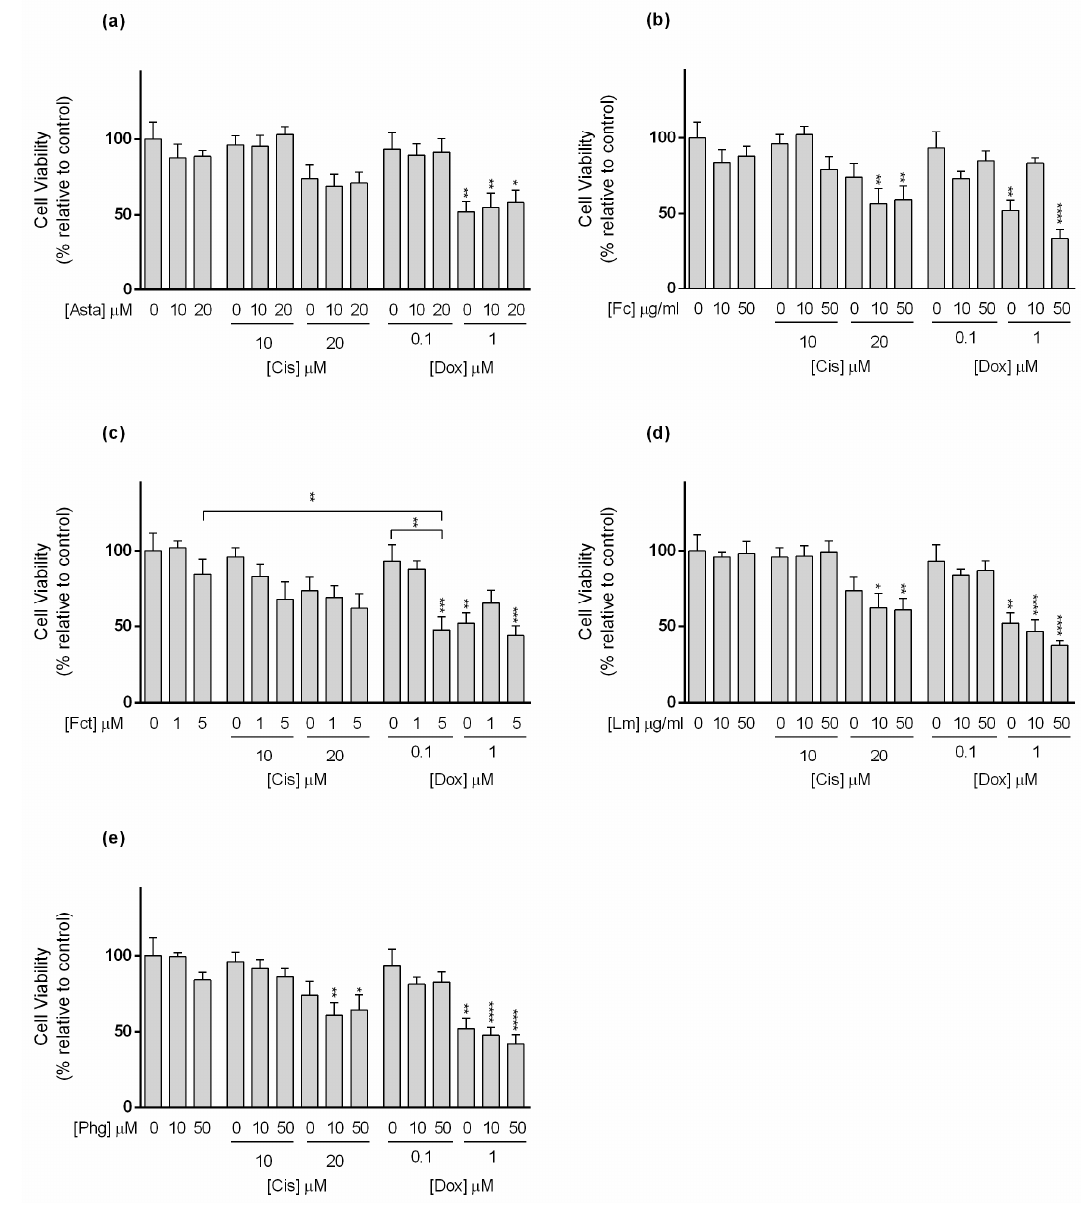
Figure 6. Cytotoxic effects of the combination of ( a ) Astaxanthin (Asta); ( b ) Fucoidan (Fc); ( c ) Fucosterol (Fct); ( d ) Laminarin (Lm); ( e ) Phloroglucinol (Phg) with the reference drugs cisplatin (Cis) and doxorubicin (Dox) assessed by the MTT assay after 72 h of exposure in MDA-MB-231 cell line cultured in monolayer. Control corresponds to cells incubated with medium containing 0.1% DMSO. The percentages of cell viability are relative to the control and presented as mean + standard deviation of six independent experiments (each in triplicate). Square brackets indicate t tests with Sequential Bonferroni corrections. (* p < 0.05, ** p < 0.01; *** p < 0.001, **** p < 0.0001). In relation to Dox, alone at 1 µ M, it negatively affected cell viability. When combined with Fc (10 µ g/mL) and Fct (1 µ M), Dox at 1 µ M seemed to have lost its action, while